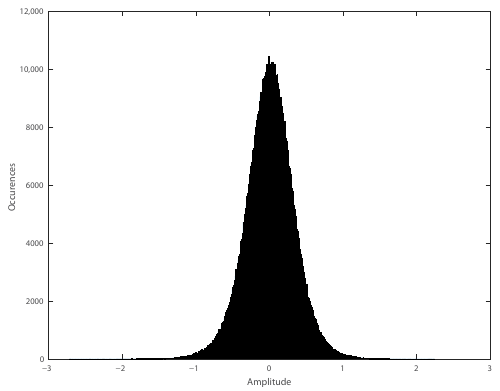
Figure 6. Distribution of measured signals’